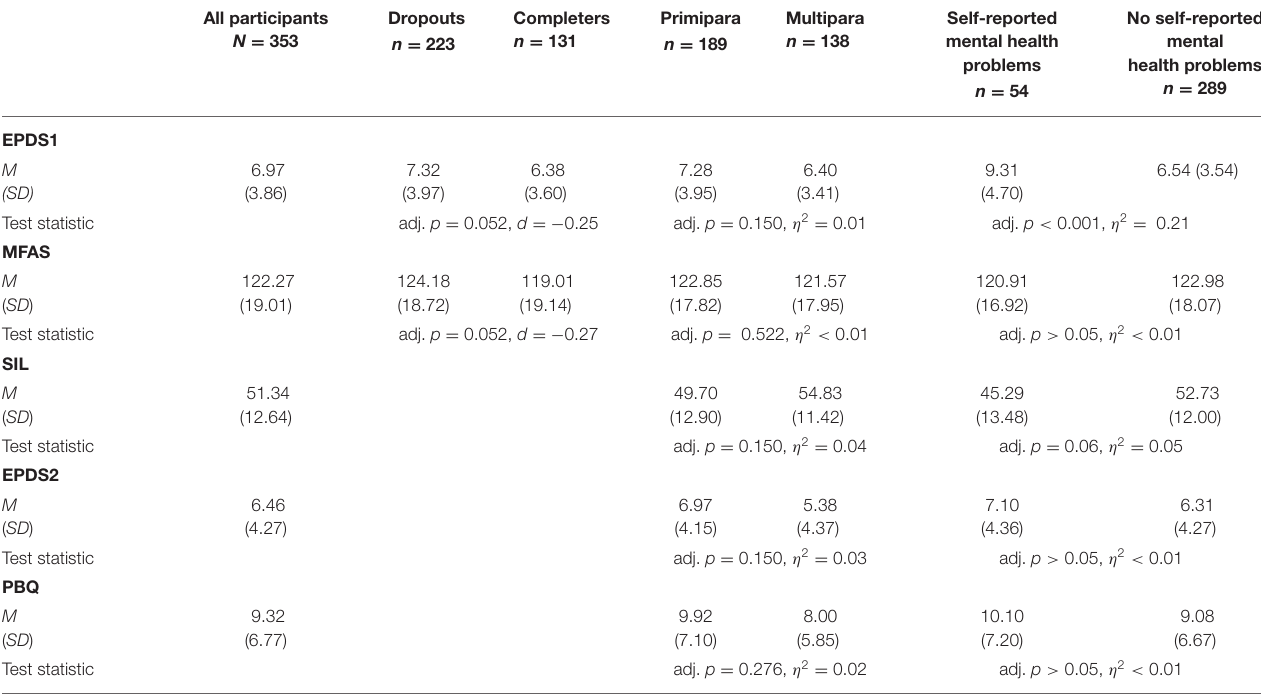
TABLE 1 | Descriptive Data of interval scaled variables.